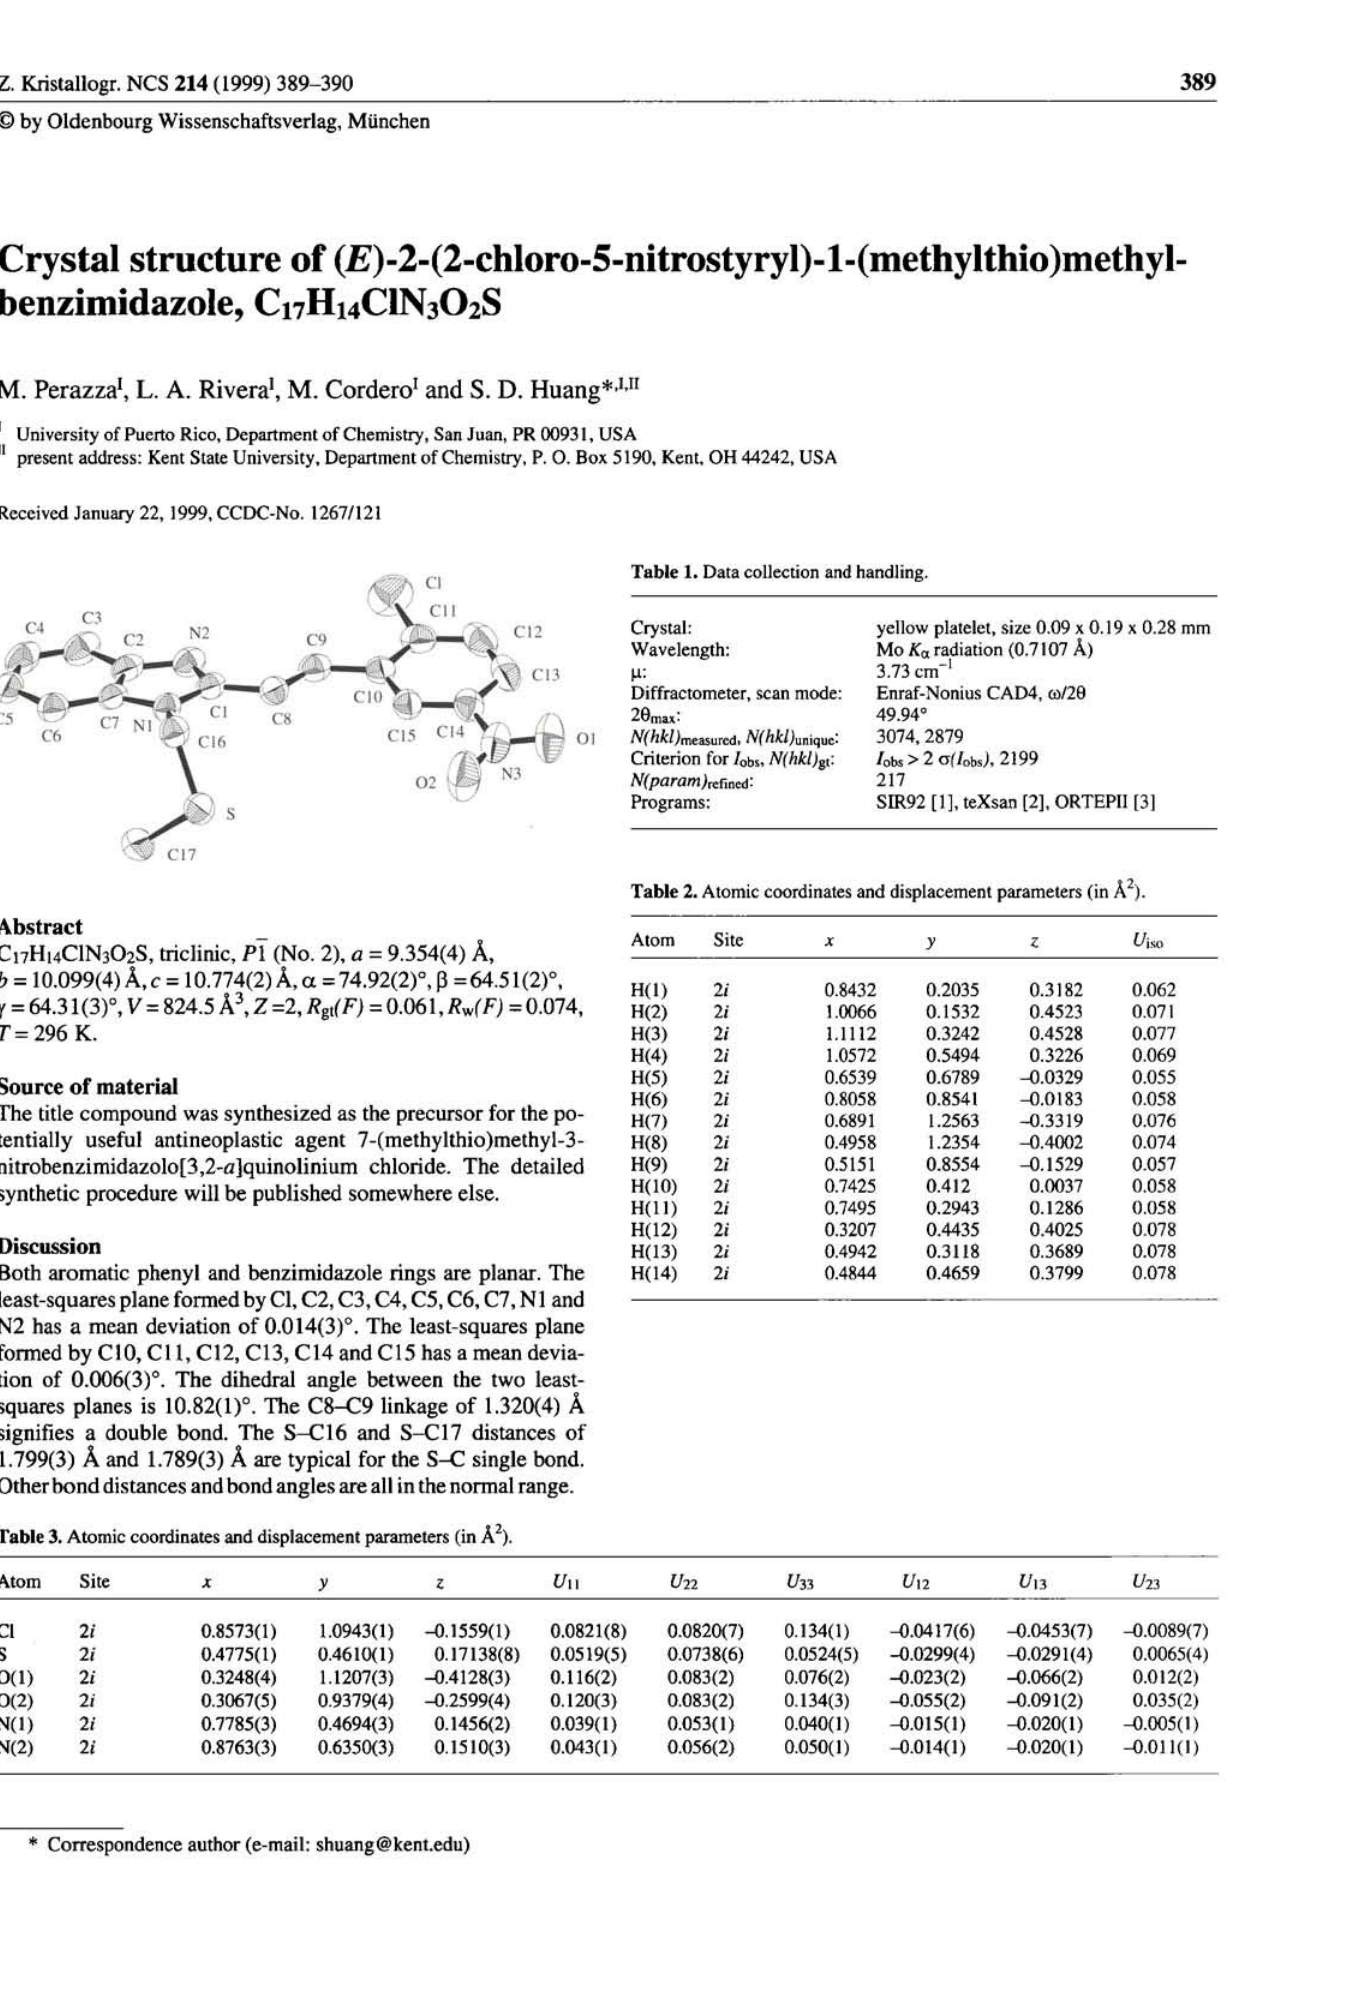
Table 3. Atomic coordinates and displacement parameters (in Â 2 ).